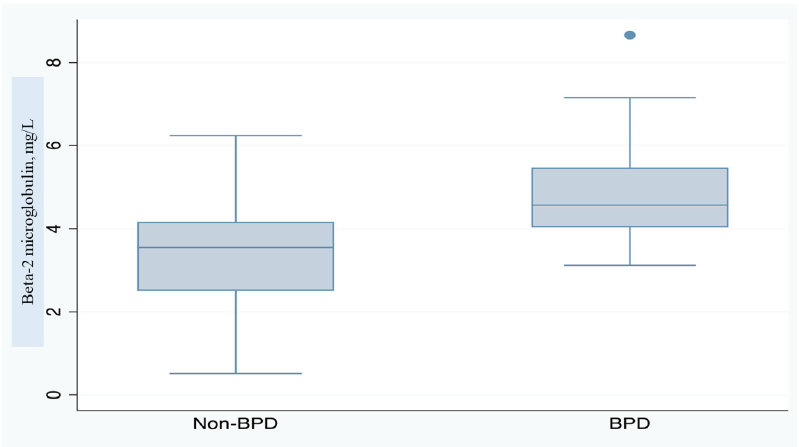
Figure 2: β 2-M levels of the groups.